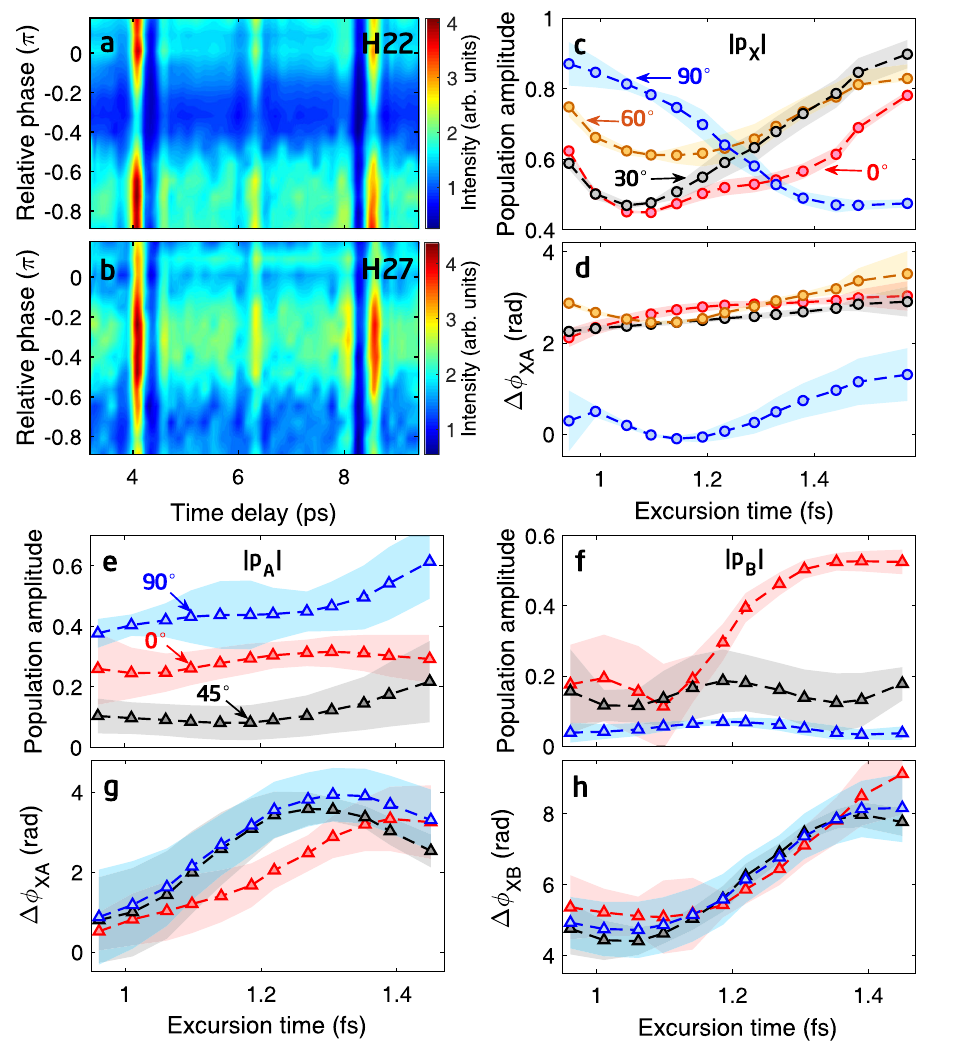
Fig. 2 | Two-color HHS scheme for probing molecular charge migration in N 2 and CO 2 . a , b Measured harmonic signals of H22 and H27 in the two-color experimentofN 2 .Measurementsatdifferentrelativephasesofthetwo-colorlasers provide suf fi cient data sets for resolving the multichannel electronic dynamics. c , d Reconstructedpopulationamplitudeofthe ~ X state( ∣ p X ∣ )andtherelativephase betweenthe wavefunctions of ~ X and ~ A states ( Δ ϕ XA ) inN 2 for the alignment angles of 0° (red circles), 30° (black circles), 60° (orange circles), and 90° (blue circles), respectively. Each circle represents the excursion time of a single harmonic order, Fig. 3c. Figure 3a presents hole densities extracted at the recombi- nation times of harmonics H15 to H26. Here, t = 0 is when electron is born. In the fi gures, the frames are separated by steps of about 50 as.